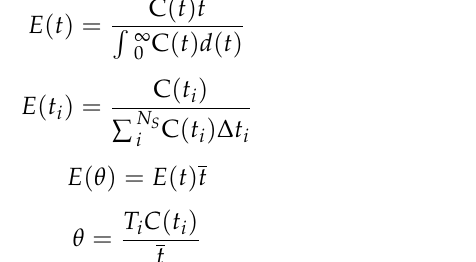
Figure 11. Comparison of the dimensionless staying time of walnuts